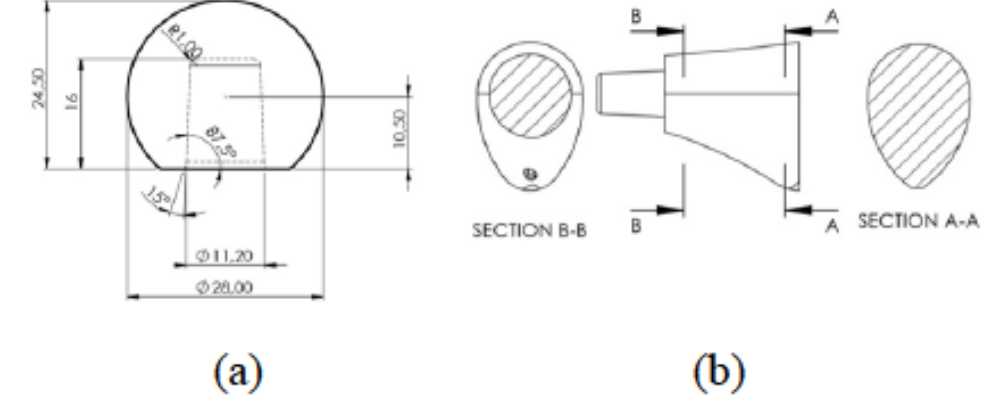
Figure 1: (a) Size dan shape of femoral head; and (b) Cross section femoral neck